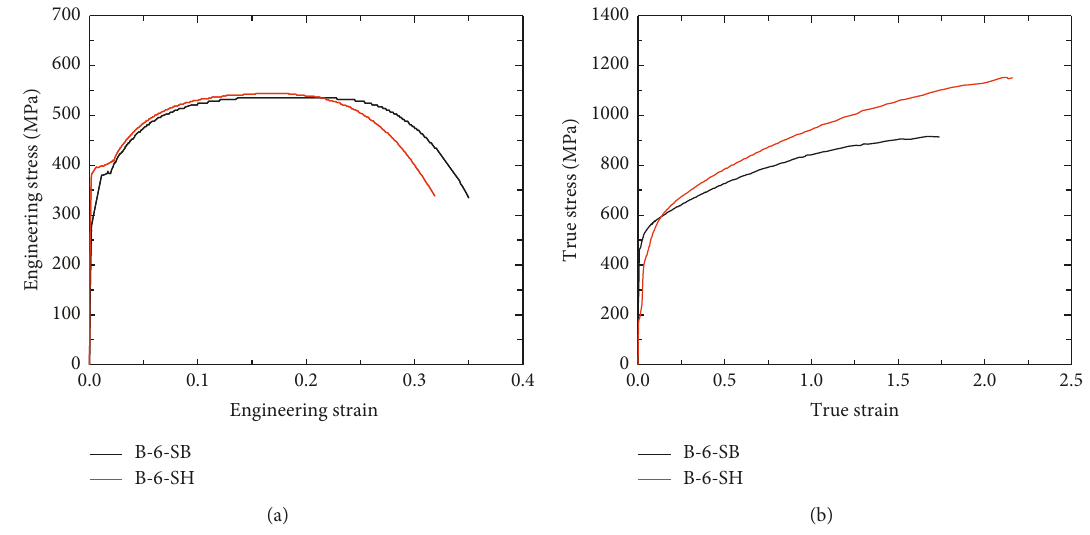
Figure 10: Stress-strain curve of standard specimens. (a) Engineering stress-strain. (b) True stress-strain.